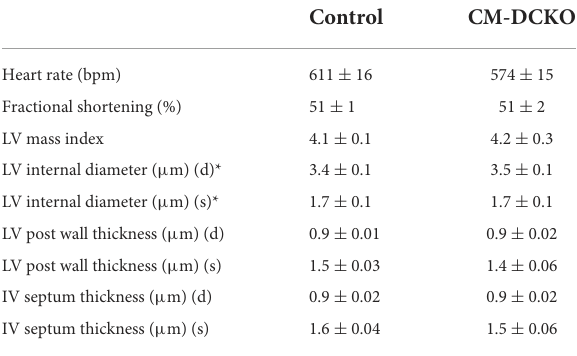
TABLE 1 Baseline echocardiographic parameters for CM-DCKO mice.